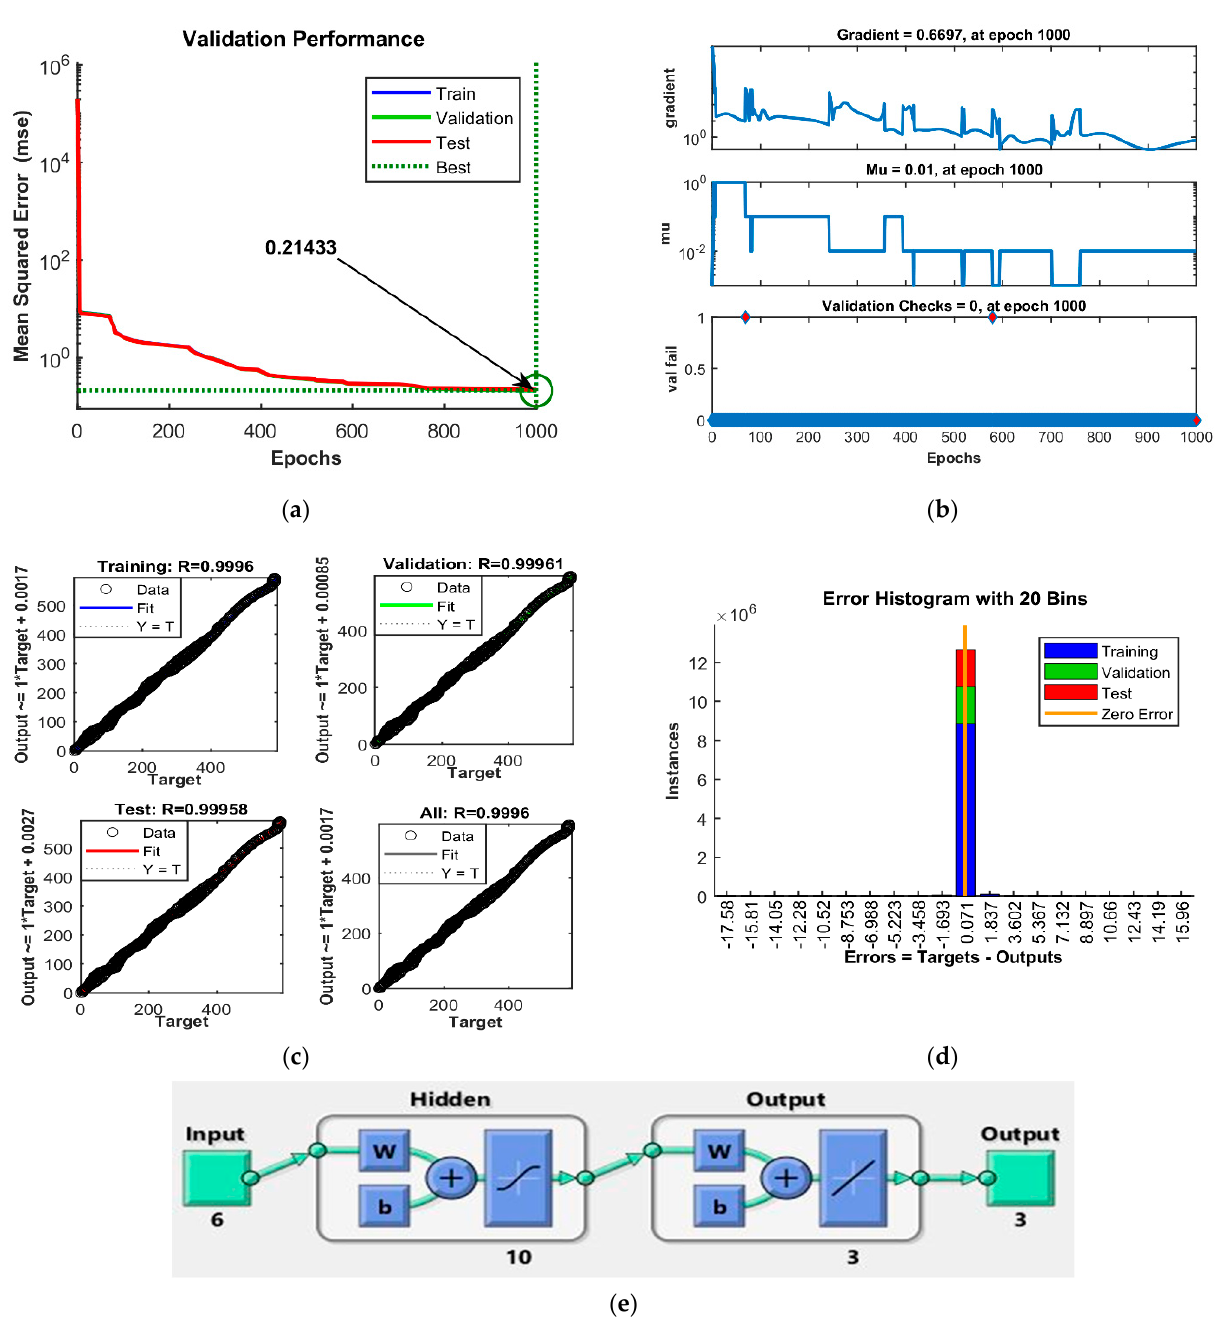
Figure 5. ( a ) Validation performance, ( b ) Training state, ( c ) Regression plot, ( d ) Error histogram, ( e ) Final trained neural network.